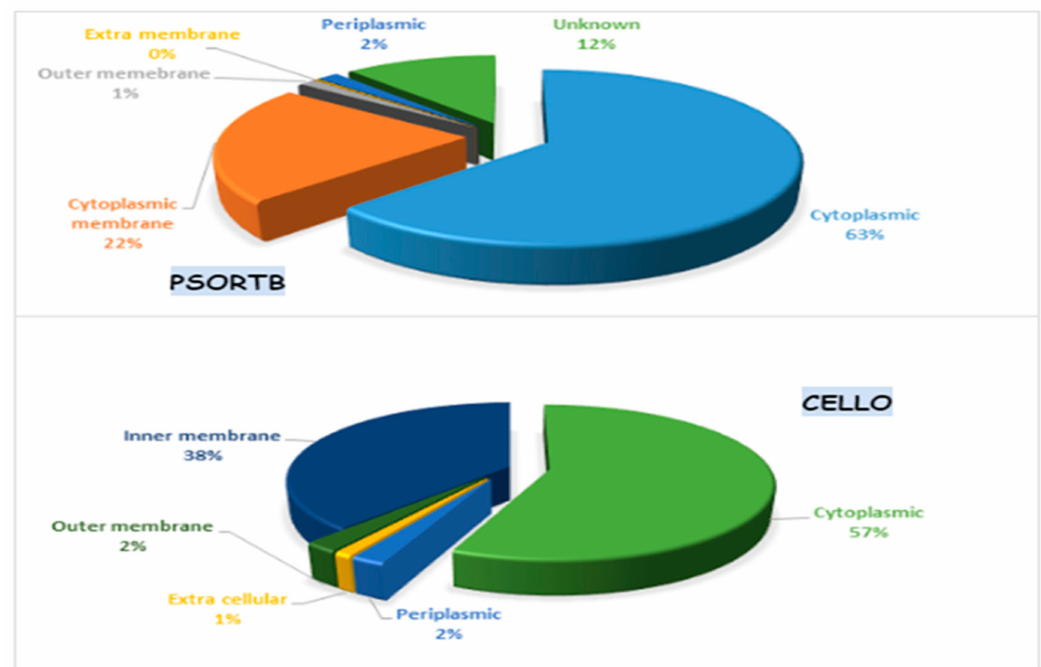
Figure 2. Subcellular localization of essential proteins predicted by PSORTB CELLO server. PSORTB predicted 63% cytoplasmic, 22% cytoplasmic membrane, 2% periplasmic, 1% outer membrane, 0% extra membrane and 12% unknown proteins, while Cello showed 57% cytoplasmic, 38% inner membrane, 2% periplasmic, 1% extracellular and 2% outer membrane